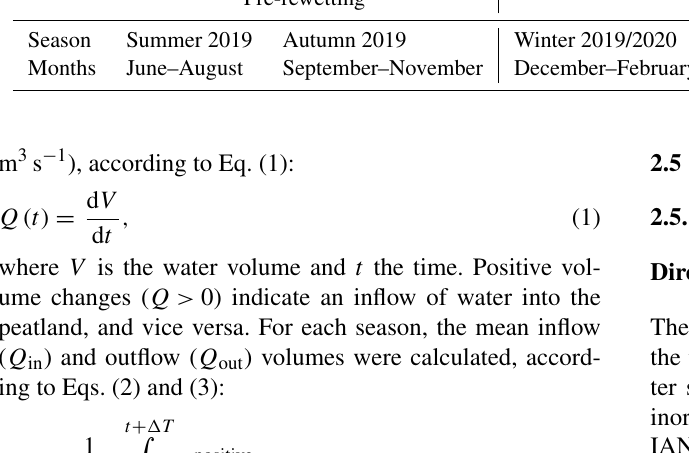
Table 1. Defined seasons of the investigation period.